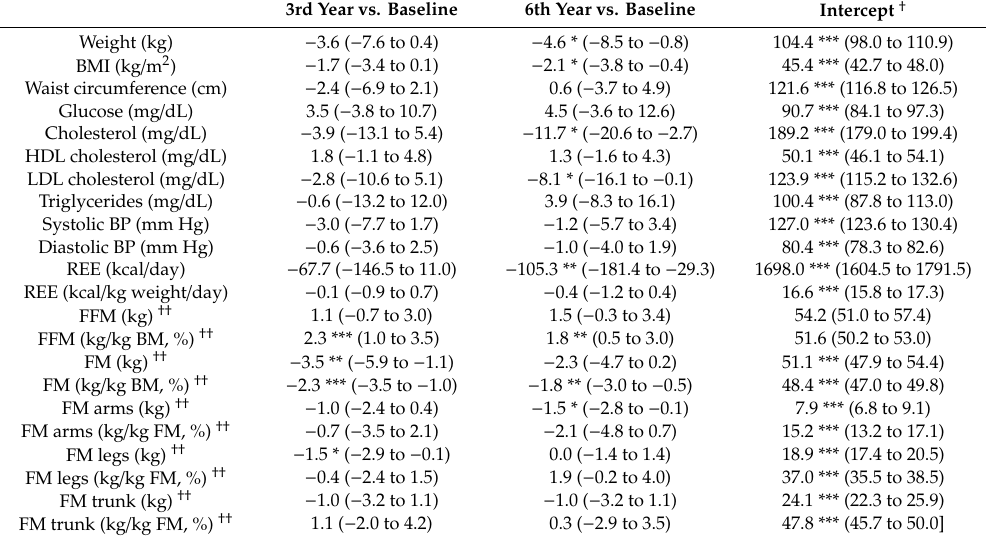
The intercept is the baseline mean estimated by random-e ff ects linear regression (see Table 3). †† Available for 36 (80%) of 45 patients (see Table 1). * p < 0.05, ** p < 0.01, *** p < 0.001. Values are means and 95% confidence